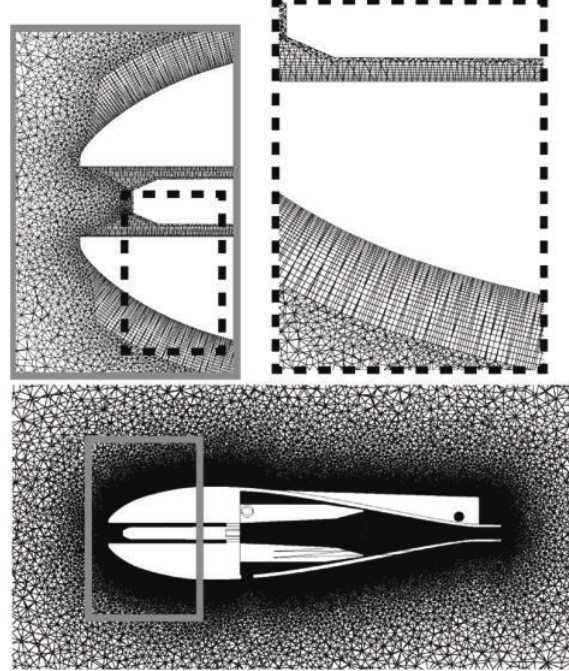
Figure 1: The computational mesh deployed in the fluid.